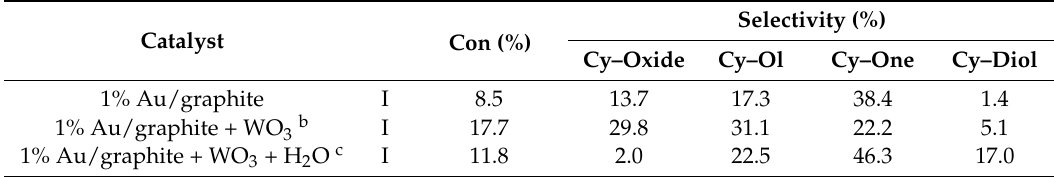
Table 2. Effect of the addition of water to cyclohexene oxidation reaction a .